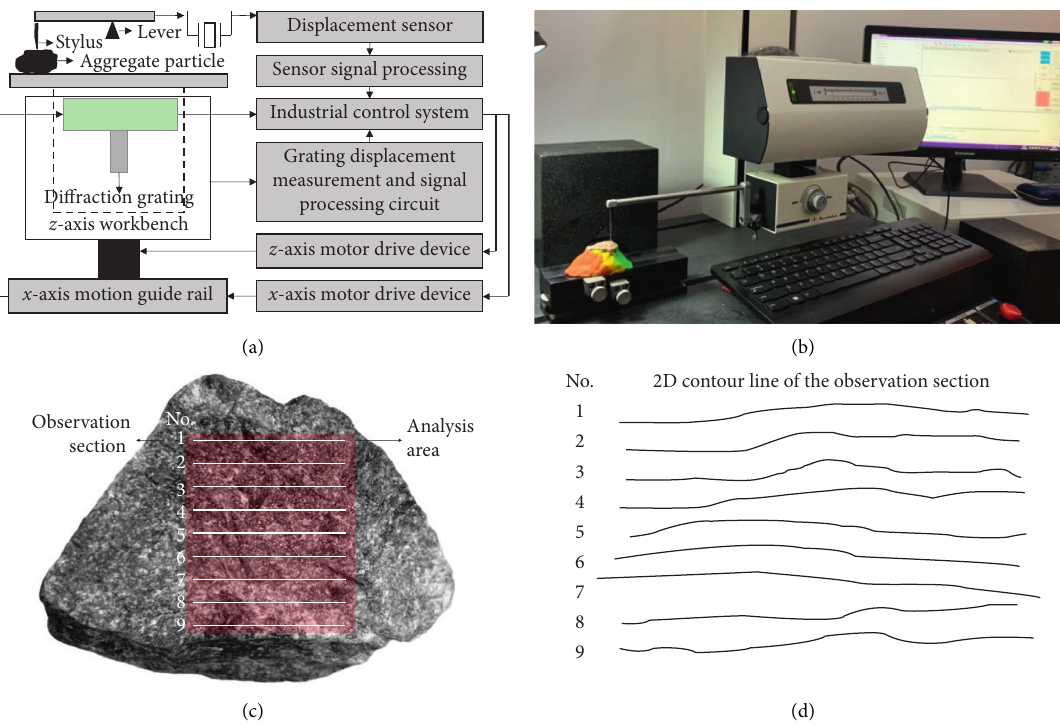
Figure 1: Collection method of 2D profile curves of the aggregate. (a) Principle of the needle-tracing method. (b) High-precision stylus profiler. (c) Observation section of the aggregate surface. (d) 2D profile curve of the observation